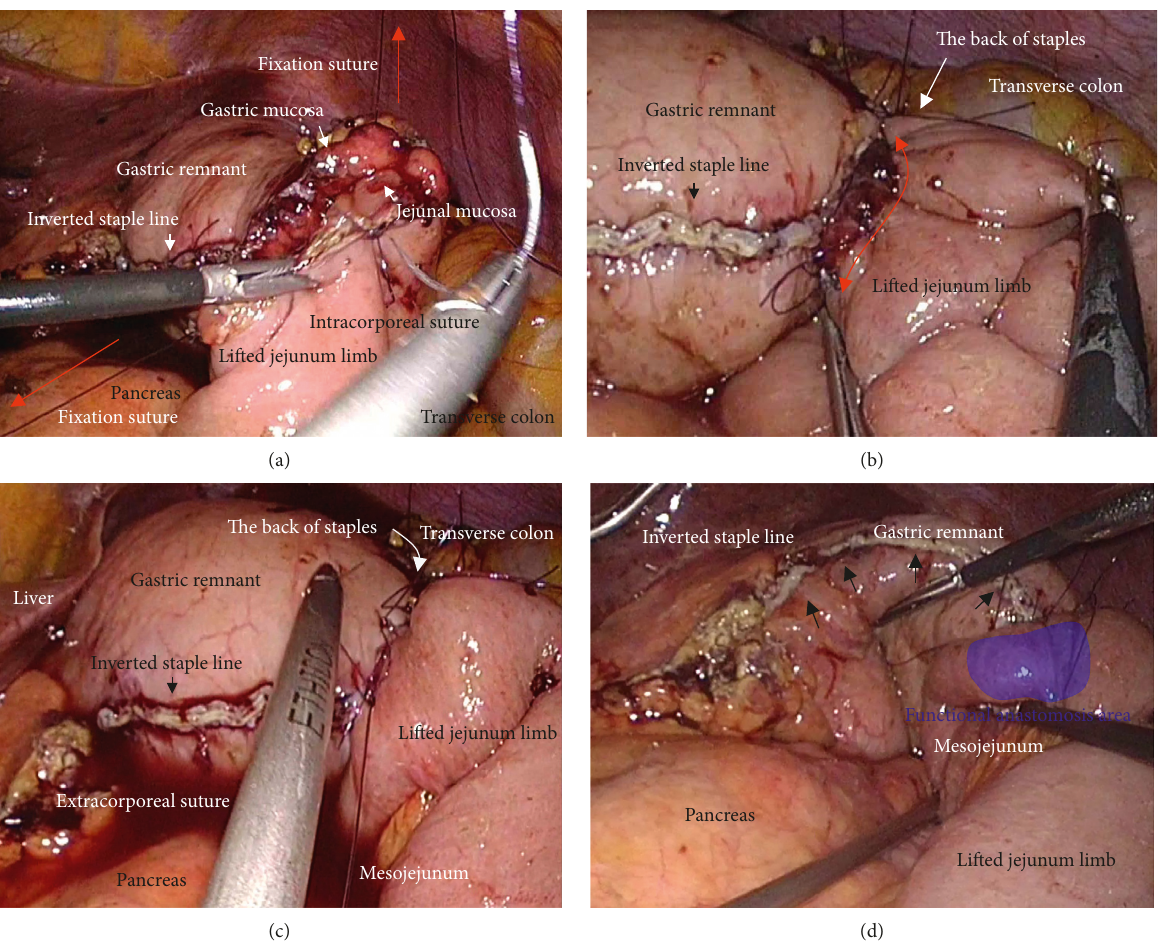
Figure 6: Actual findings via laparoscope during intracorporeal procedures were shown. Co-author, (T) Hori, mainly performed this surgery. (a) The jejunum was lifted through the antecolic route. The sacrificed jejunum contributed well to ideal mesojejunal margins in the lifted jejunal limb (blue arrow). The jejunal limb could be lifted with no tension on the retracted mesojejunum (red arrow). (b) Under countertraction by the two grasping sutures (red arrows), the endostapler was guided into the lifted jejunal limb. (c) Staple lines for surgical anastomosis should be set at 35–40mm (red arrow). The length of linear staple line was optimally adjusted in the isoperistaltic side-to-side fashion (blue arrows). (d) Postoperative passage depends on patency at the functional anastomosis (blue area). The inverted staple line in the gastric remnant was covered (yellow